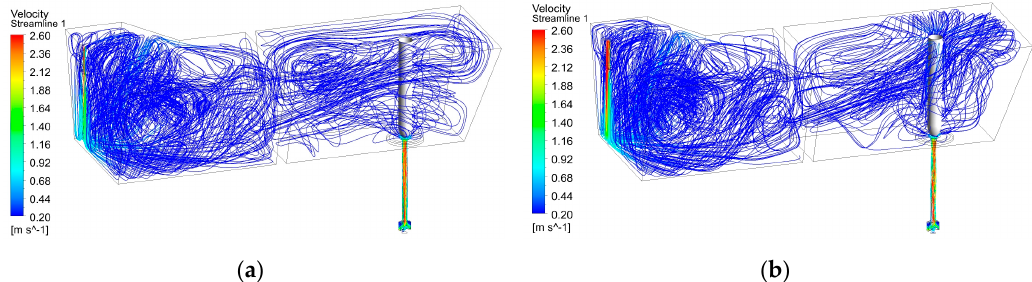
Figure 6. Velocity streamline of the liquid steel in the tundish: ( a ) without argon blowing and ( b ) with argon blowing.